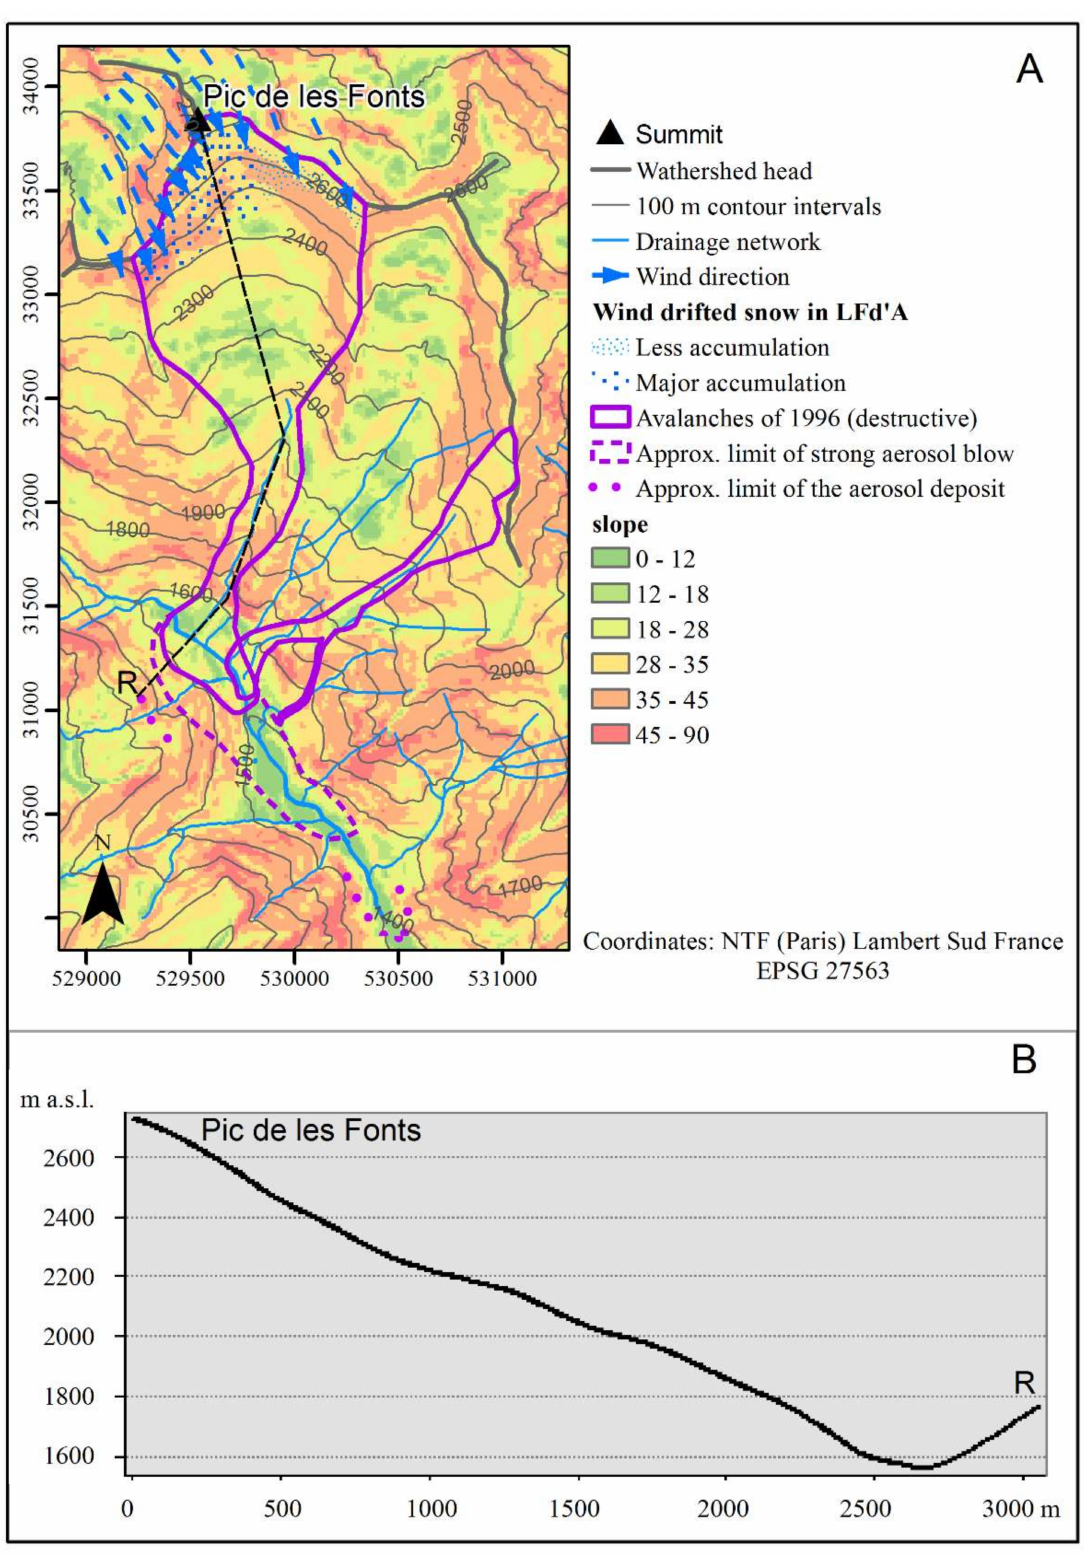
Figure 3. ( A ) Main wind direction and wind-drifted snow accumulation zones during the snowfall episode in the LFd’A avalanche path on a slope map. ( B ) Avalanche path profile indicated in